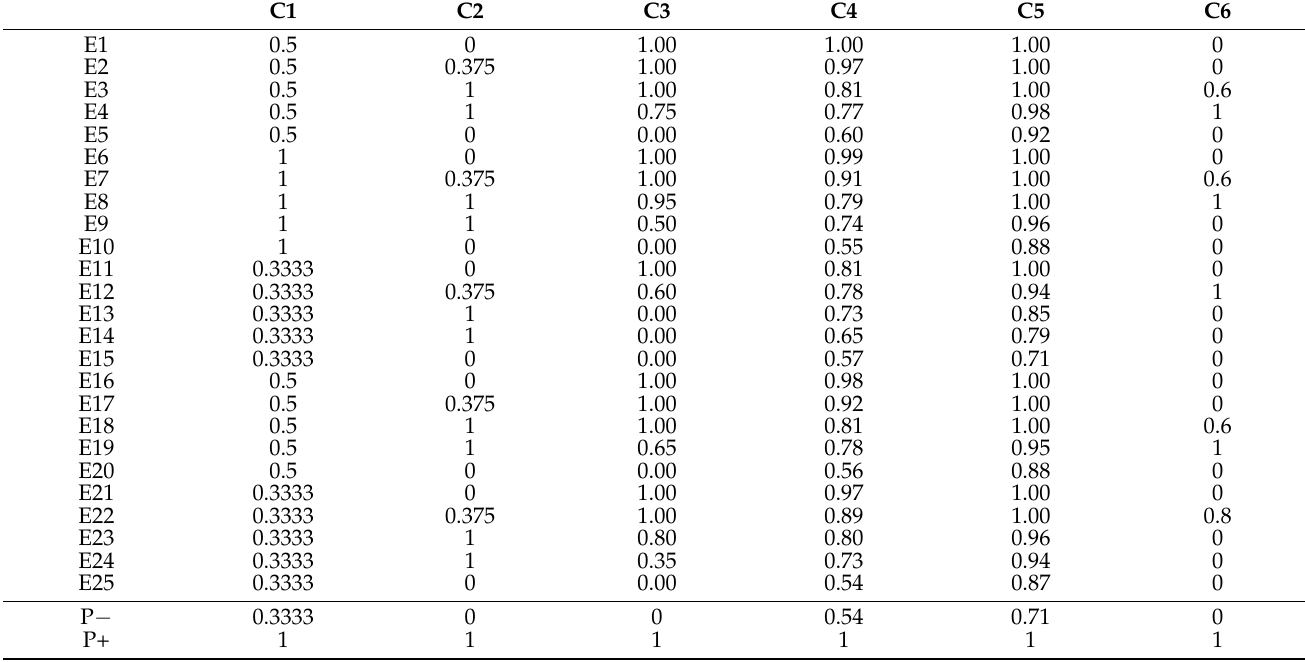
Table A1. The fuzzy decision matrix, highlighting the best option and the worst option.